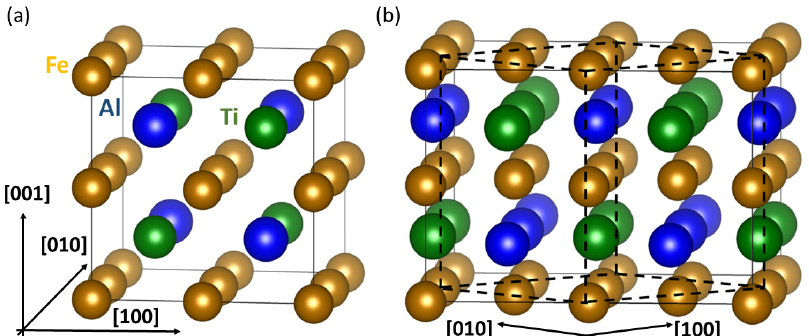
Figure 1. A schematics showing relations between a 16-atom cubic-shape supercell of stoichiometric Fe 2 TiAl with the Heusler L2 1 structure ( a ) and a 32-atom supercell ( b ) of the type which we used for our study. The dashed lines in the part ( b ) show the 45 ◦ -rotated 16-atom cell exhibited in part ( a ).